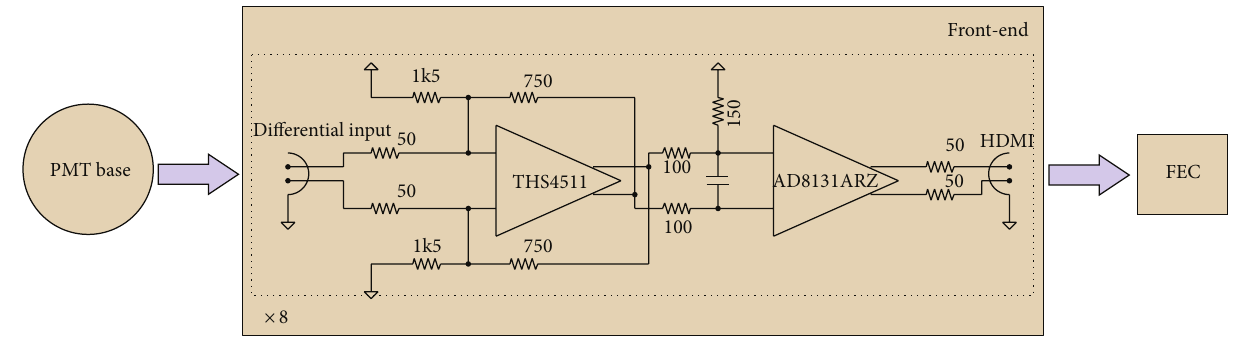
Figure 16: Scheme of the front-end for the energy